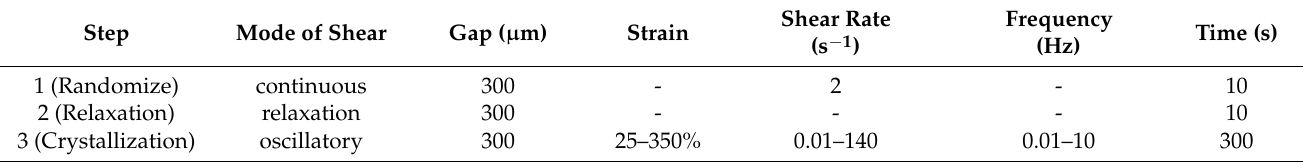
Table 1. Standard three-step sequence used in the shear-cell characterization of opal samples. The mode of shearing, inter-plate gap, range of strain amplitude, range of shear rate, range of oscillation frequency and cycle time are shown for each